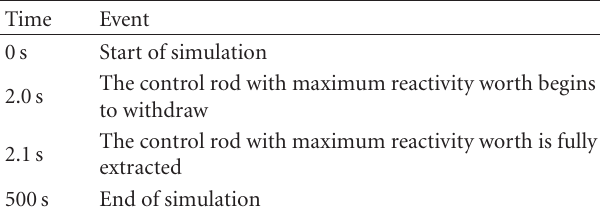
Table 3: Sequence of the events during the simulated transient.